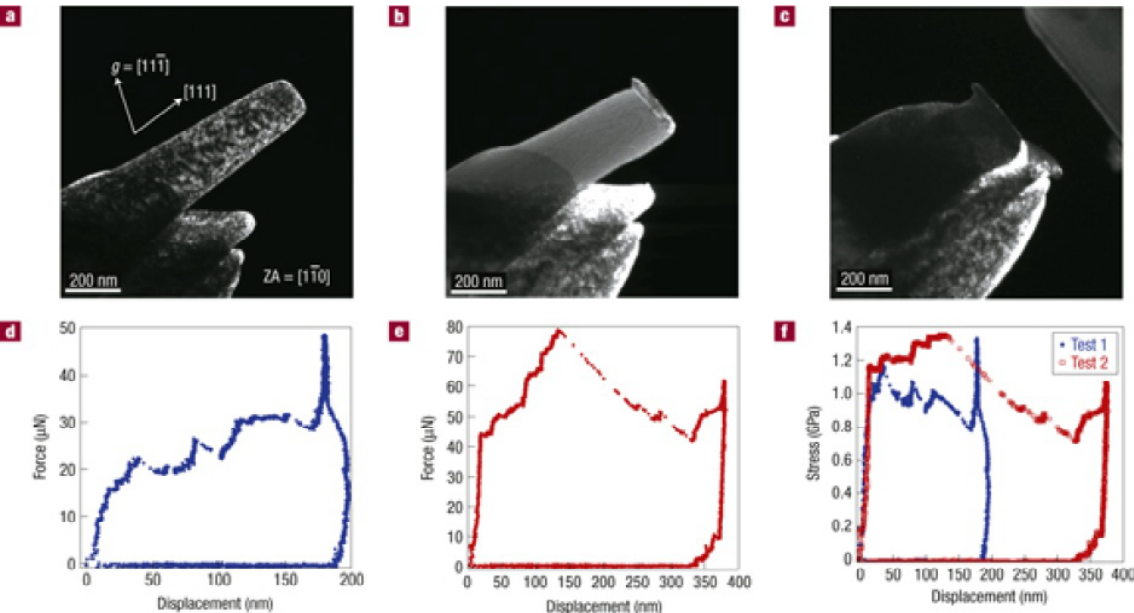
Fig. 13. In situ TEM compression of <111> oriented 160 nm Ni pillar. a) Dark-field TEM image of the pillar before the test, showing high initial dislocation density, b) Dark-field TEM image of the same pillar after the first test which is now free of dislocations, c) Dark-field TEM image of the same pillar after the second test. d) Force versus displacement curve of the first and e) second test. f) Instantaneous stress versus compressive displacement for the two tests; the apparent yield stress is similar for both tests. Reprinted with permission from Shan ZW, Mishra RK, Asif SAS, Warren OL, Minor AM. 2008. Mechanical annealing and source- limited deformation in submicrometre-diameter Ni crystals. Nature Materials 7, [28]: ©2008 Nature Publish- ing